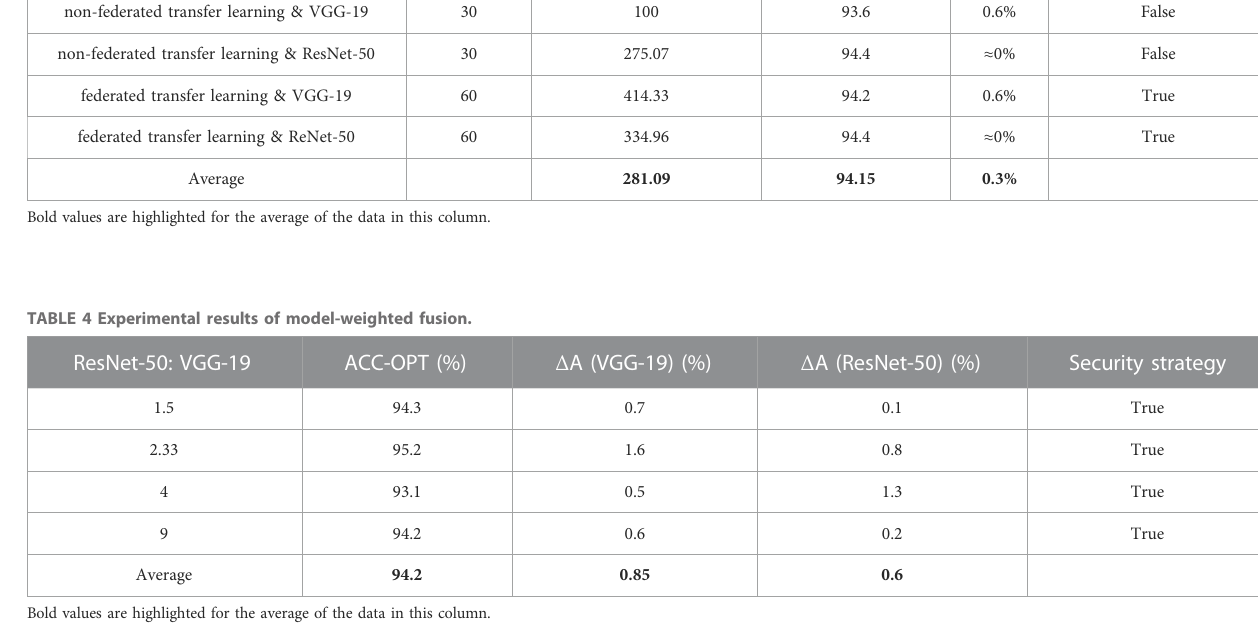
Bold values are highlighted for the average of the data in this column.